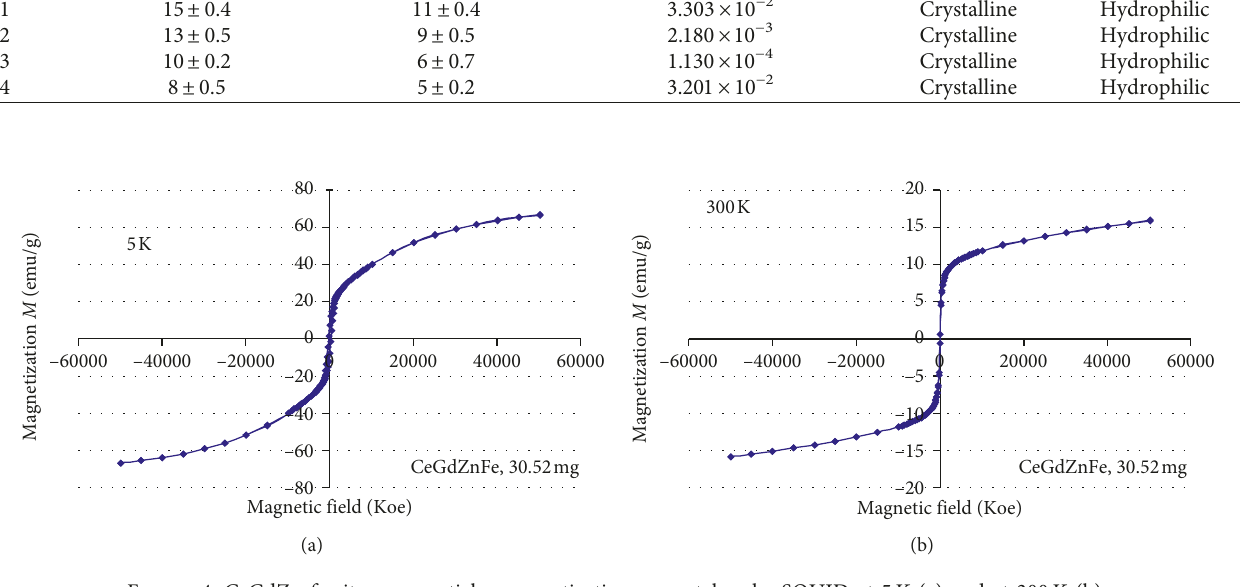
0.2 conc.] (20 mg/ml) at (cid:29)